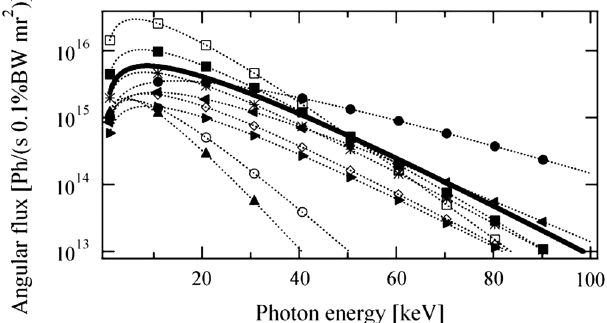
FIG. 1. Angular flux of IDs presented in Table I calculated (cid:7) ), SCW34 (*), DW200 ( h ), with SRW at 2.75 GeV: SCW60 ( W175 ( m ), W80 ( (cid:8) ), DW100 ( j ), W148 ( e ), W90 ( c ), W140 ( b ), and WSV50 (